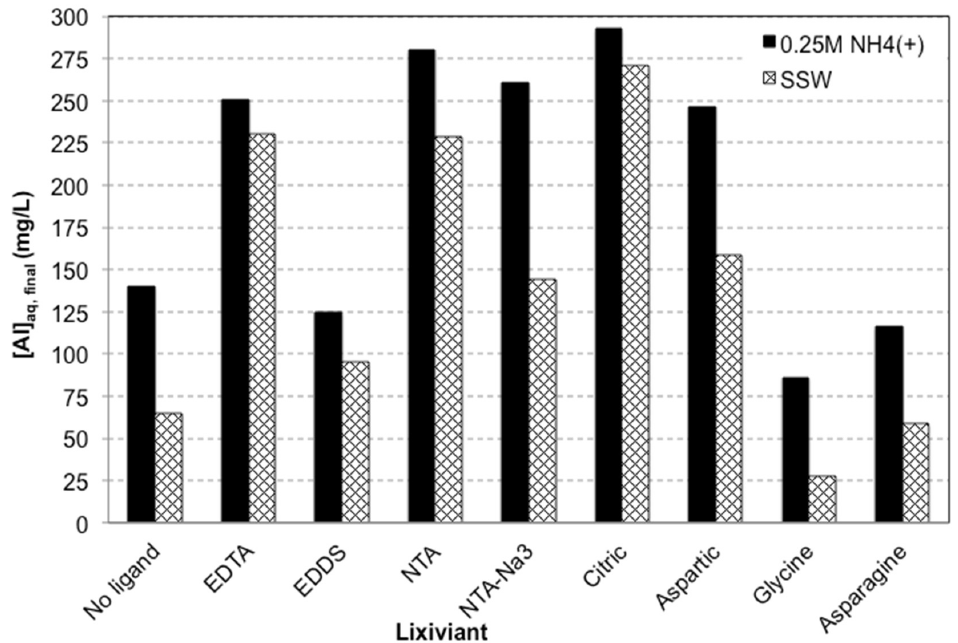
Figure 3. Aluminum concentration in the leachate (ambient conditions, 30 min, L/S = 2/1, 1:1 chelating agents).